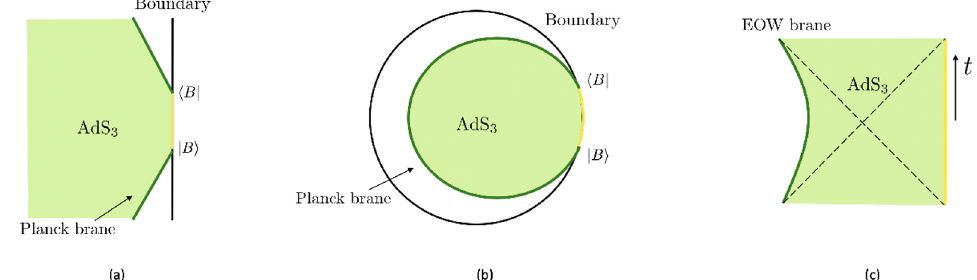
Figure 14 . We consider a doubly holographic set up, where the flat space region (yellow) is a segment of the AdS 3 boundary, while the 2d dynamical gravity regions (green) correspond to Planck branes in the 3d bulk (shaded in light green). The spatial direction is suppressed in the figure, which can be either infinite or compact and is perpendicular to the page. (a) The disconnected configuration for the Planck branes. (b) The connected configuration. (c) We can continue the connected configuration into Lorentzian signature, and the Planck brane becomes an end of the world brane behind the horizon (denoted by the dashed